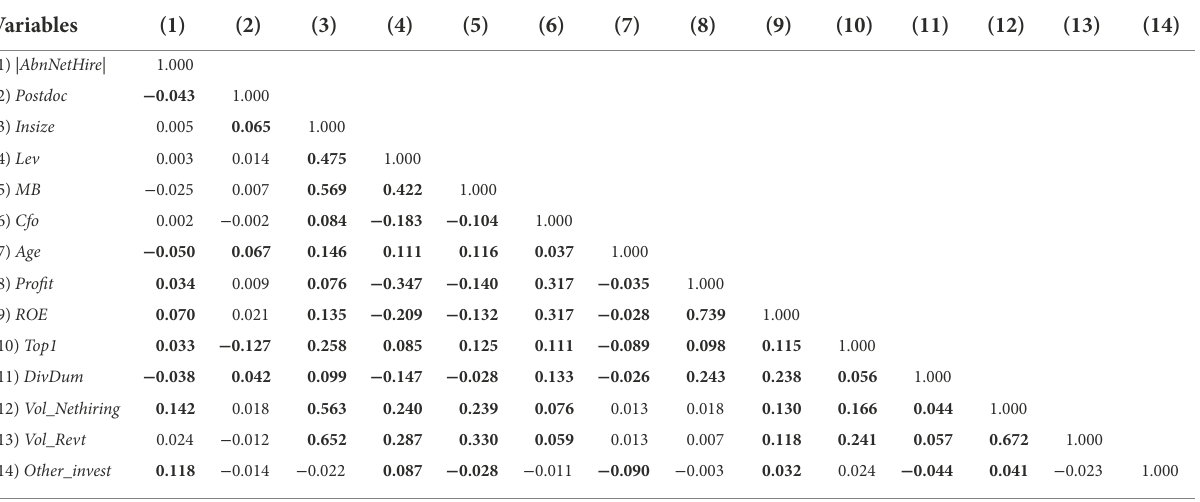
TABLE 3 Pearson